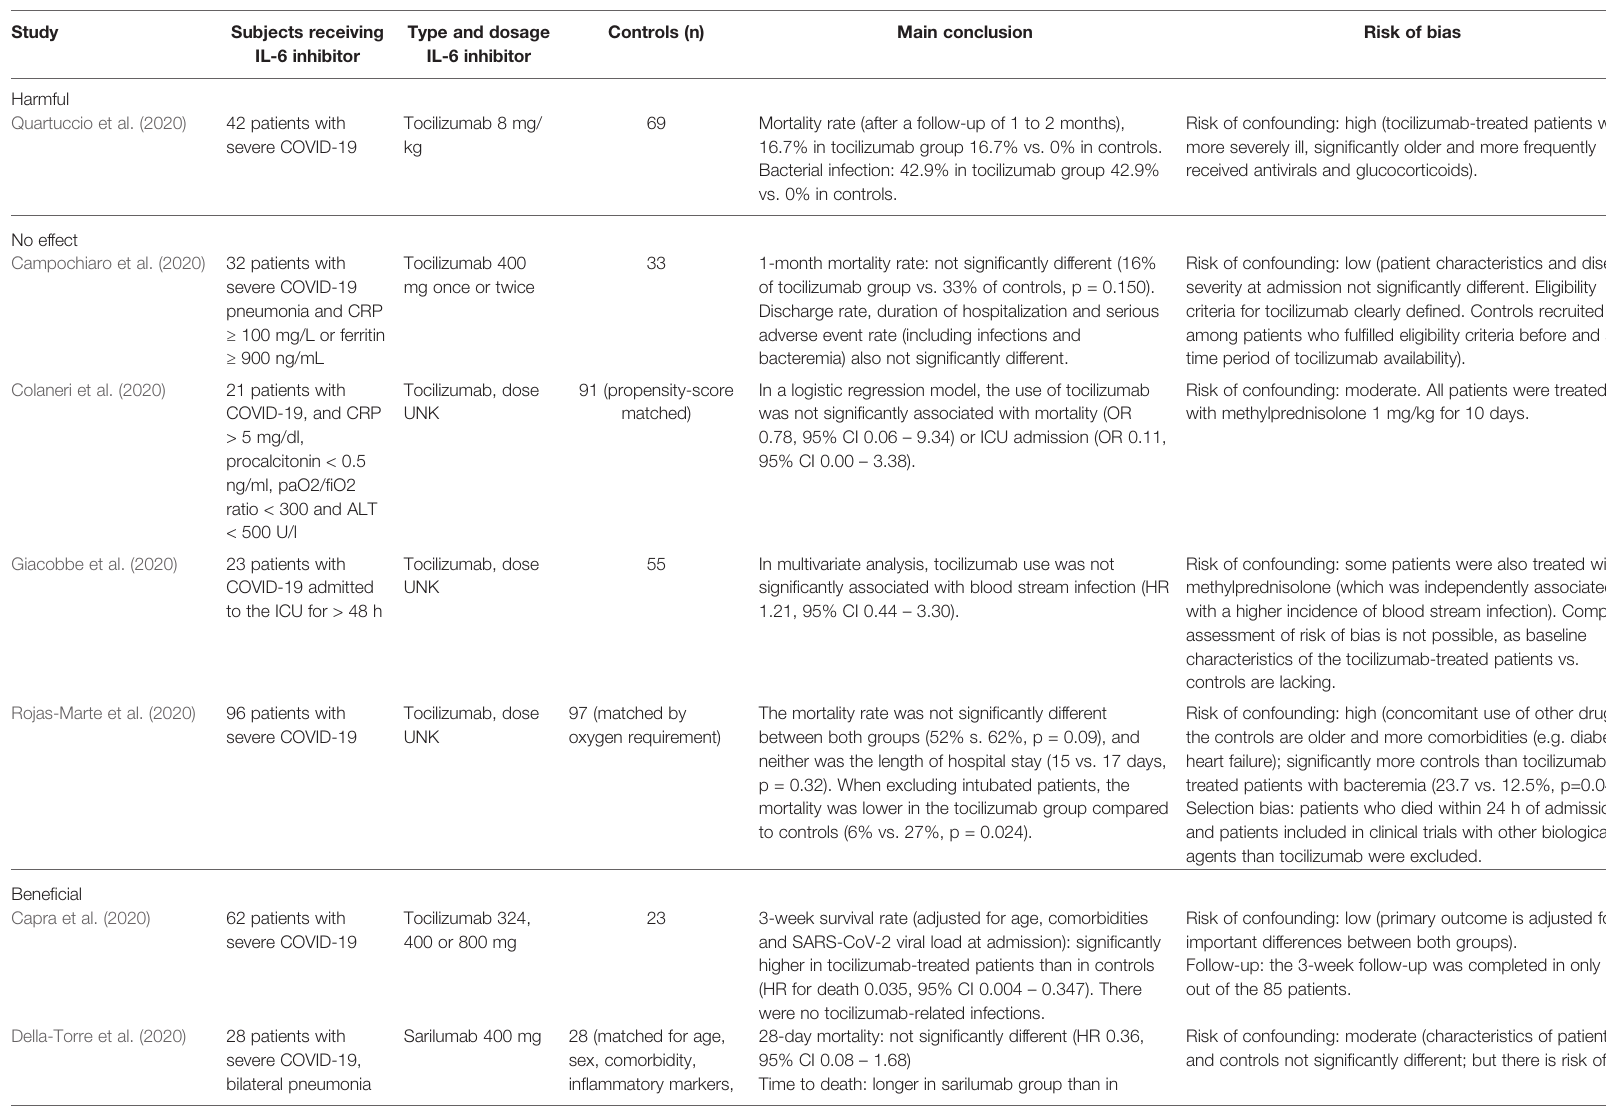
TABLE 3 | Retrospective cohort studies: IL-6 inhibitors in the treatment of patients with